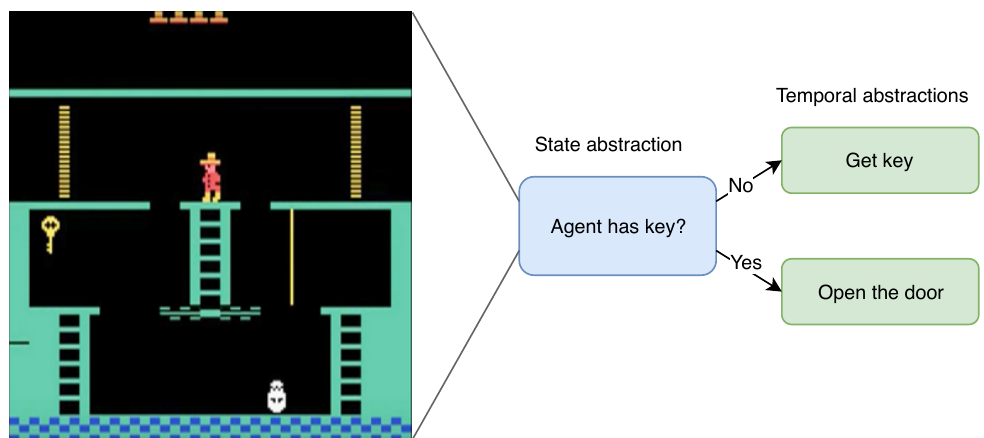
Figure 3. An example of the usage of state- and temporal- abstractions in the Monezuma’s Revenge Atari 2600 video game. The agent uses a state abstraction (agent has a key), in order to decide upon which temporally extended action to